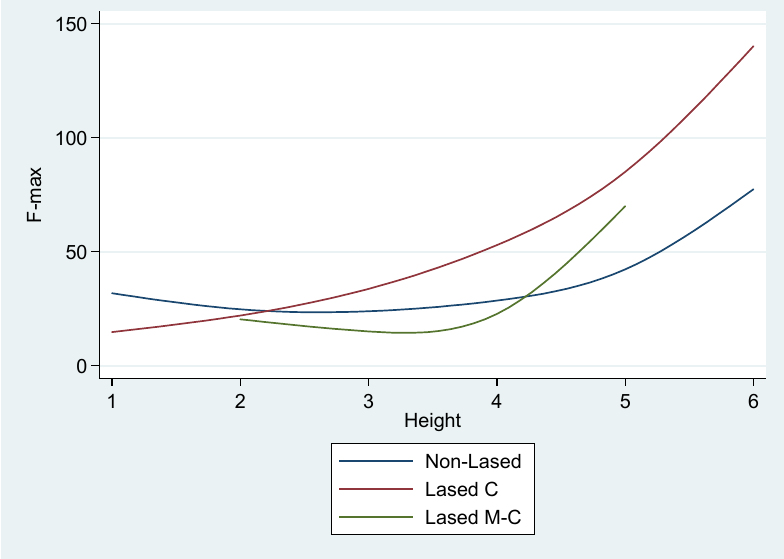
Figure 6. Predicted median F-max by height and group; results from Weibull models fitted separately to each group.